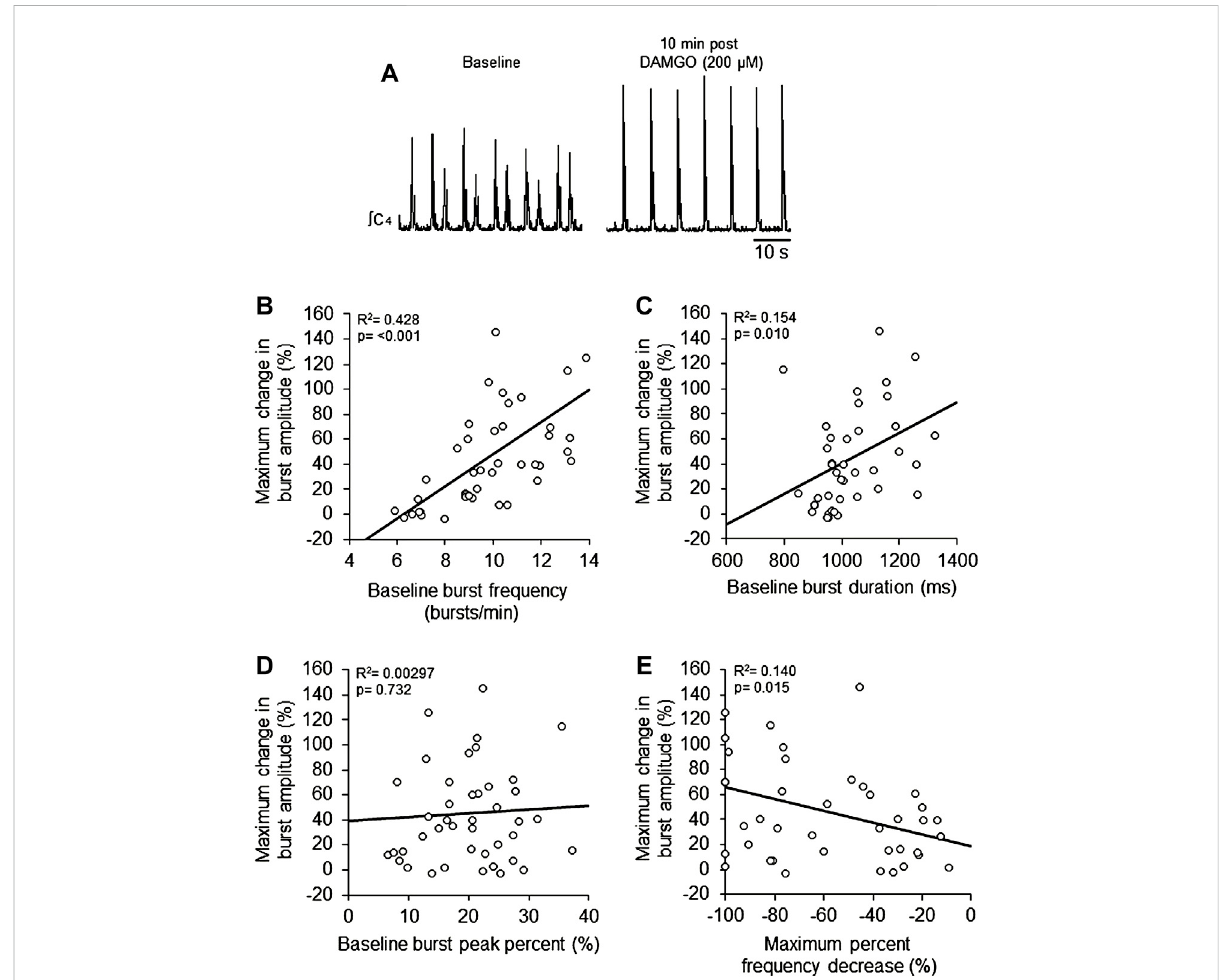
DAMGO-induced inspiratory burst amplitude increase was dependent on baseline properties of inspiratory motor burst output. (A) Voltage traces of inspiratory motor output from a brainstem-spinal cord preparation with a relatively high baseline burst frequency (left), and the large burst amplitudeincreaseat10-minpost-DAMGOadministration(right).Linearregressionanalysisofmaximumchangeinburstamplitudewerecompared to: (B) baseline burst frequency, (C) baseline burst duration, (D) baseline burst peak percent, and (E) maximum percent decrease caused by DAMGO applications. Preparations with relatively higher baseline burst frequencies (B) and longer burst durations (C) exhibited larger DAMGO- induced increases in inspiratory burst amplitude. DAMGO-induced increases in inspiratory burst amplitude were inversely proportional to the magnitude of burst frequency decreases during DAMGO application